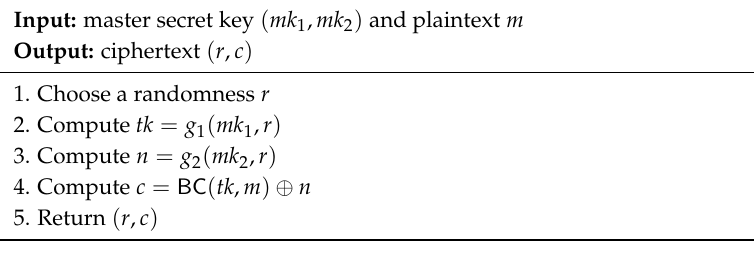
Algorithm 3 First-order SCA-resistant re-keying encryption scheme: enc 2